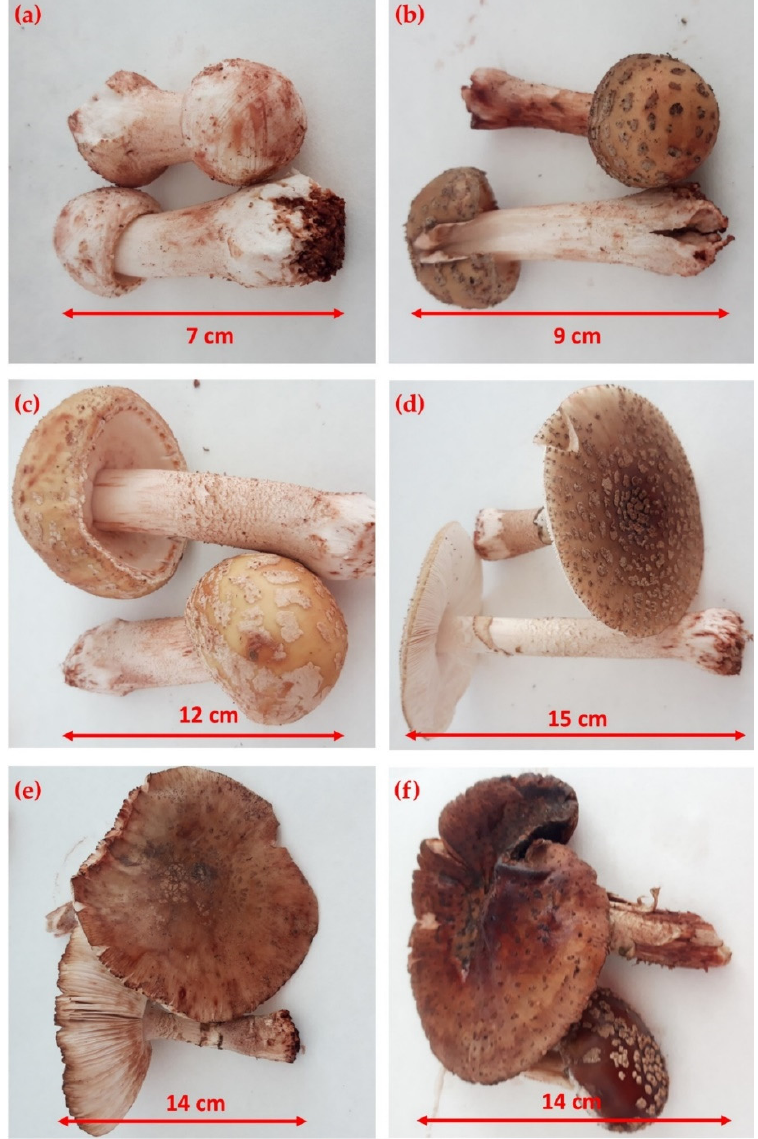
Figure 2. Different developmental stages of Amanita rubescens Pers: ( a ) 2nd–3rd day of fructification;